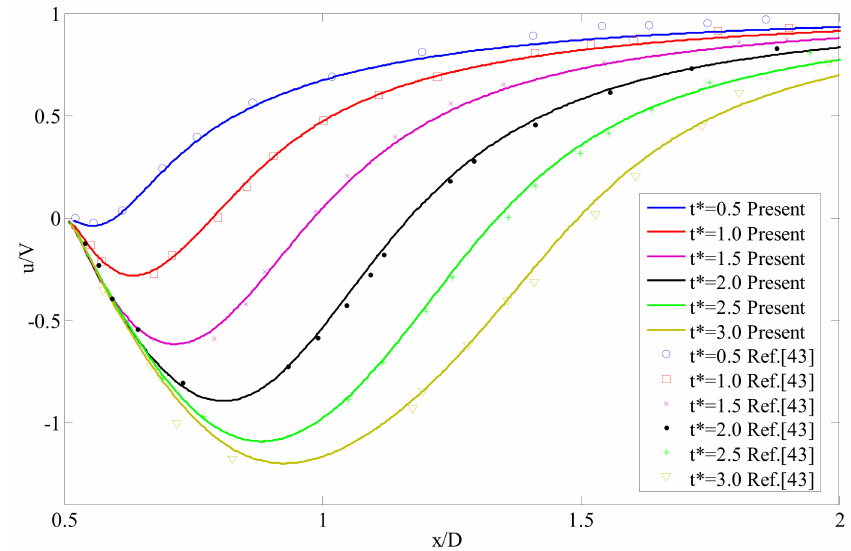
Figure 5. The comparison of the velocity distribution on the axis between the present solutions and the results of Reference [43] for Re = 550.